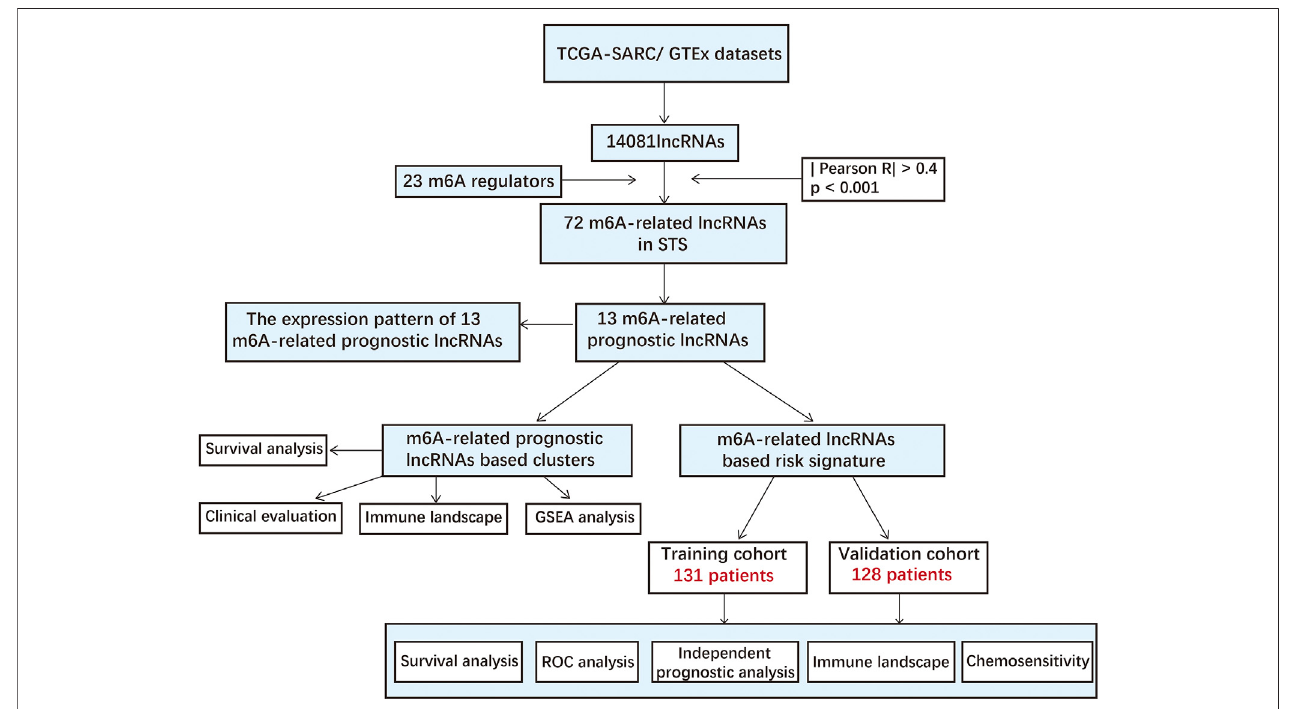
FIGURE 1 | Flow diagram of this